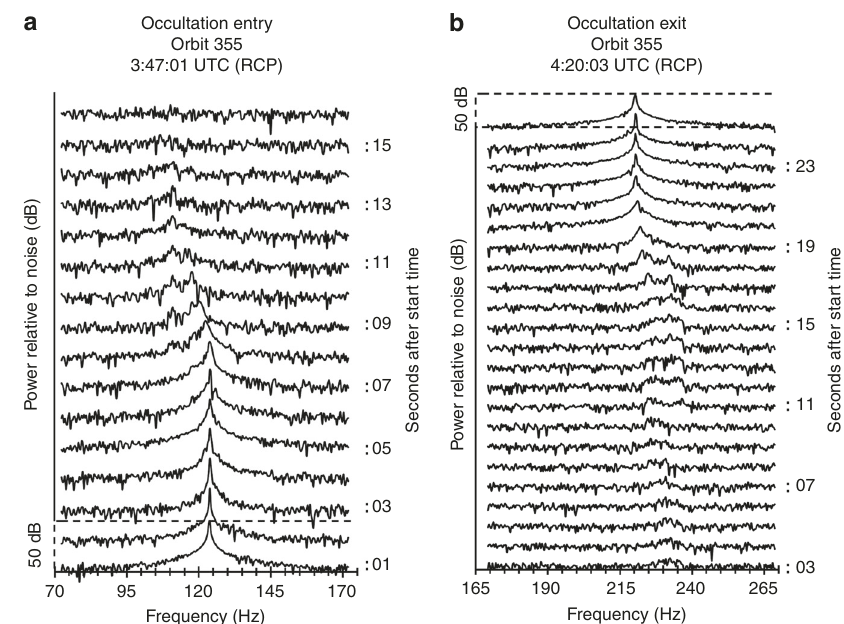
Fig. 2 Progression of received radar signal throughout entrance into and exit from occultation during orbit 355. Occultation entry a spans ~16 s while occultation exit b spans ~25 s. Each spectrum is generated from two averages of 2.5-s integrated spectra, corresponding to a total of 5 s of radar data that start at each listed timestamp. Spectra are vertically offset for display purposes, where each successively higher spectrum corresponds to a step forward